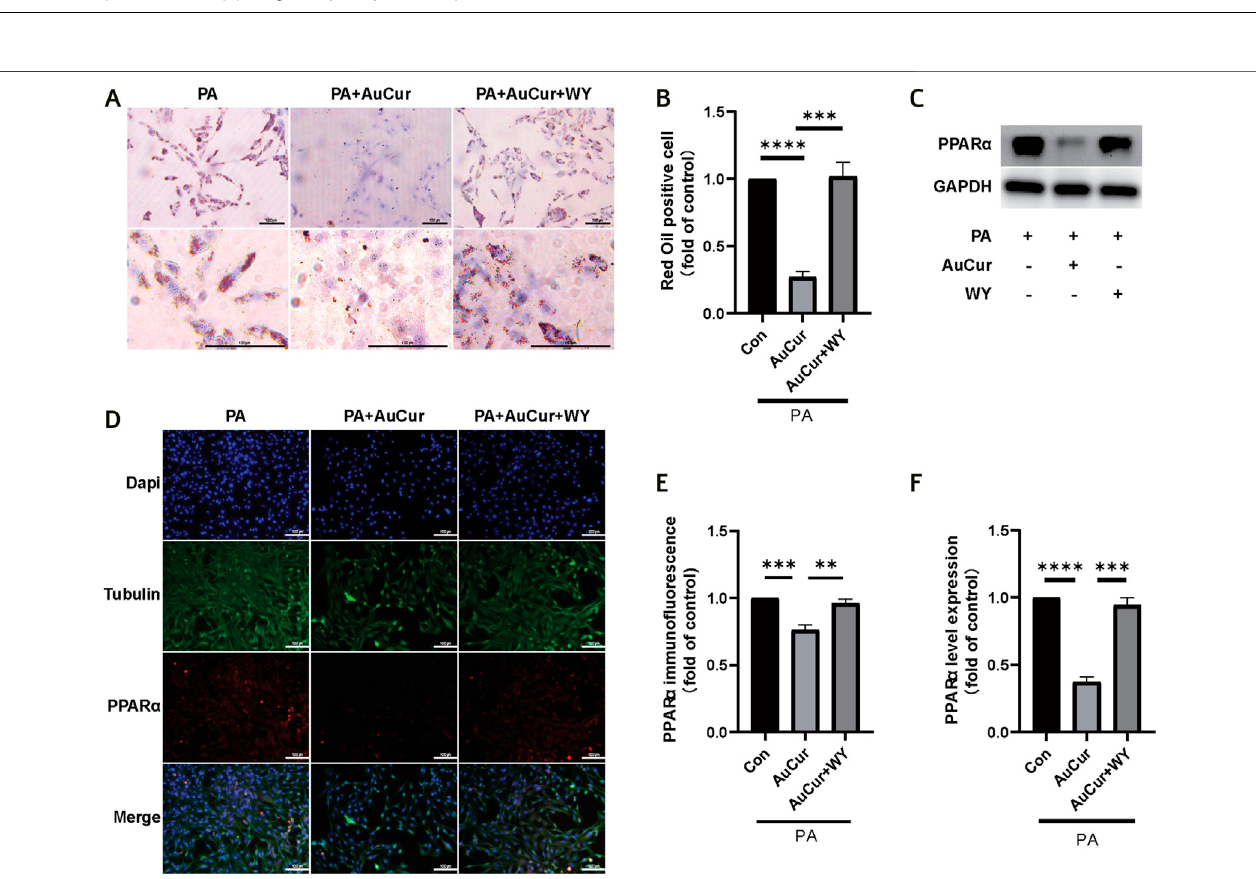
FIGURE6| AuCuraffectslipidaccumulationbyregulatingPPAR α . (A) MyocardialH9C2cellswerestainedwithoilredOtreatedwithPA,PA+Cur,andPA+AuCur + WY, respectively. Scale bar: 100 μ m. (C) The expression of PPAR α wasdetected byWB. GAPDH was used as an internal reference. (D) PPAR α fl uorescence images of PA, PA + Cur, and PA + AuCur + WY groups. Scale bar: 100 μ m. (B) Oil red fat droplet analysis. (F) PPAR α WB banding analysis. (E) PPAR α fl uorescence image analysis. * p < 0.05.